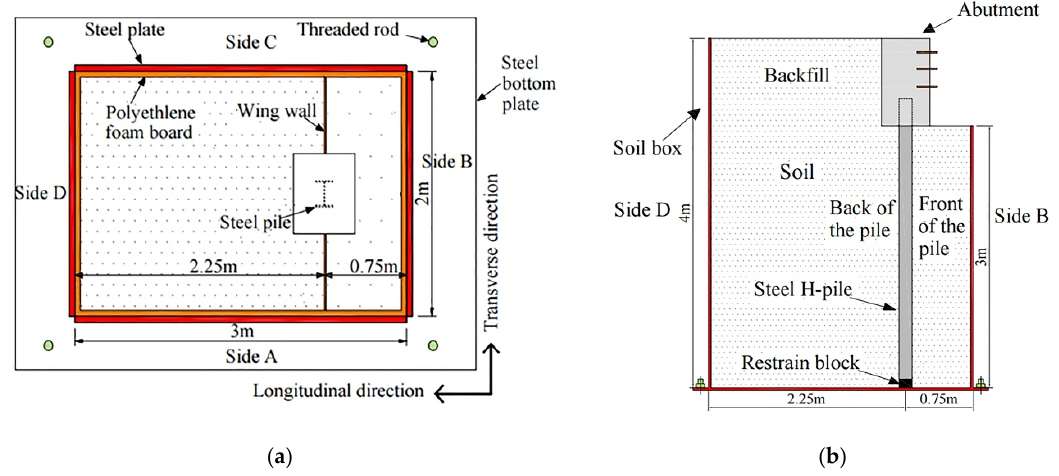
Figure 3. Test layout (unit:m). ( a ) Top view of specimen and soil box. ( b ) Elevation view.